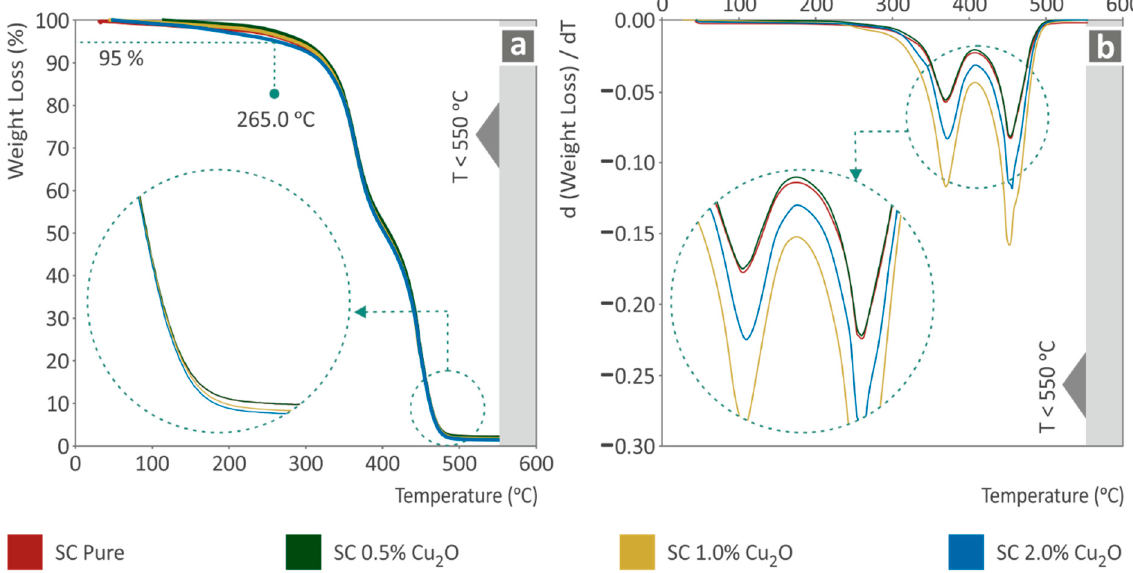
Figure 4. ( a ) Sample’s weight (%) to temperature (°C), ( b ) weight loss rate (mg/mg) to temperature (°C).